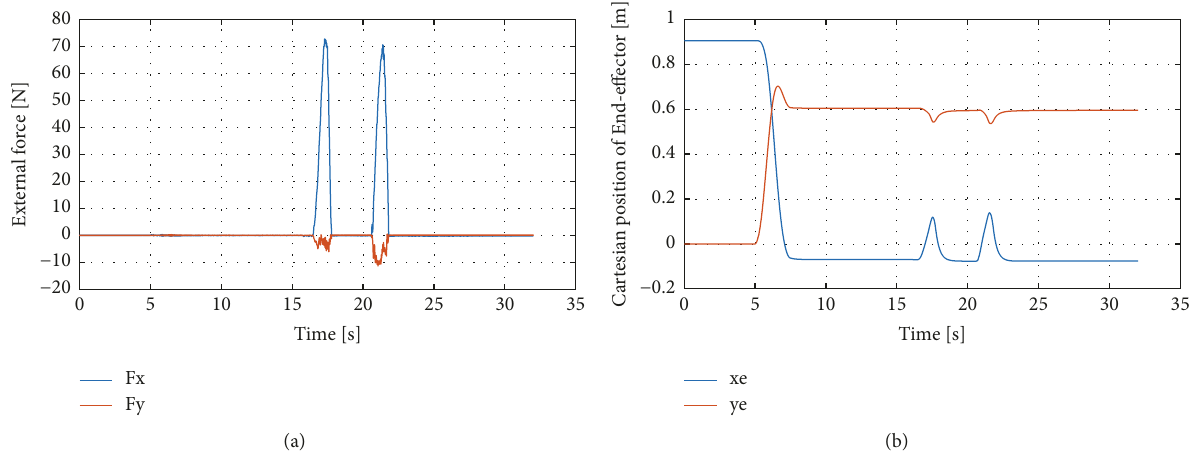
Figure 5: Experimental results of standard impedance control. (a) External forces. (b) End-effector position in Cartesian space.